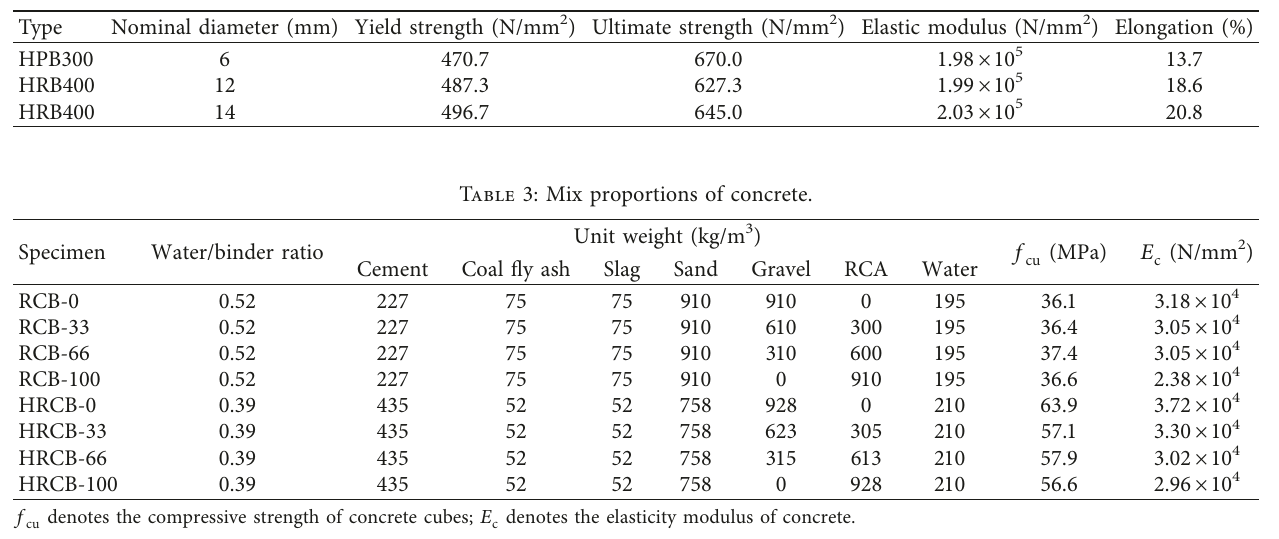
Table 2: Mechanical properties of the steel bars.